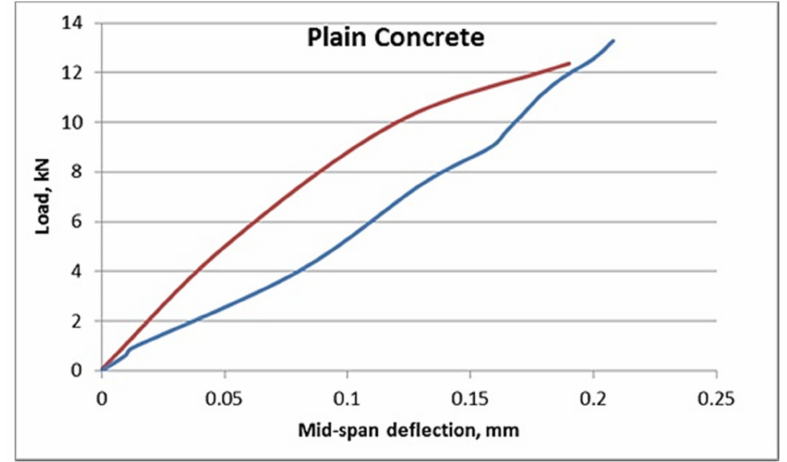
Figure 5. Load-deflection of unreinforced concrete beams at